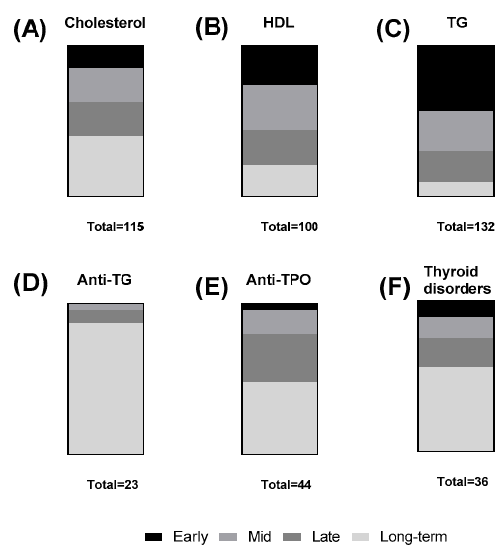
Figure 7. The time of lipid and thyroid disorders occurrence with respect to the clinical post-transplant classification. The boxes represent the percentage of each class among patients that had the specific lipid disorder. ( A ) cholesterol disorder ( n = 115); ( B ) HDL disorder ( n = 100); ( C ) Triglycerides disorder ( n = 132); ( D ) Anti-TG occurrence ( n = 23); ( E ) Anti-TPO occurrence ( n = 44); ( F ) Thyroid disorder ( n = 36).